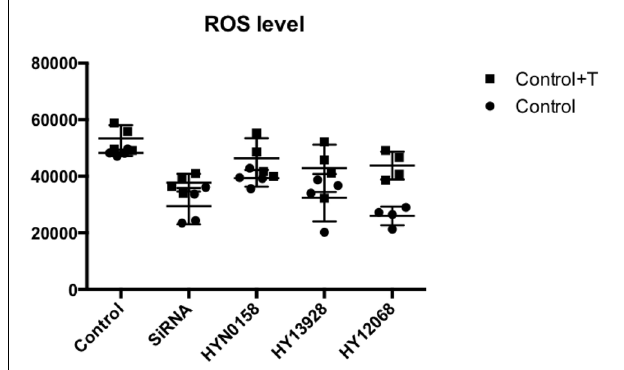
FIGURE 9 | Measurement of ROS level. The ROS generation of each